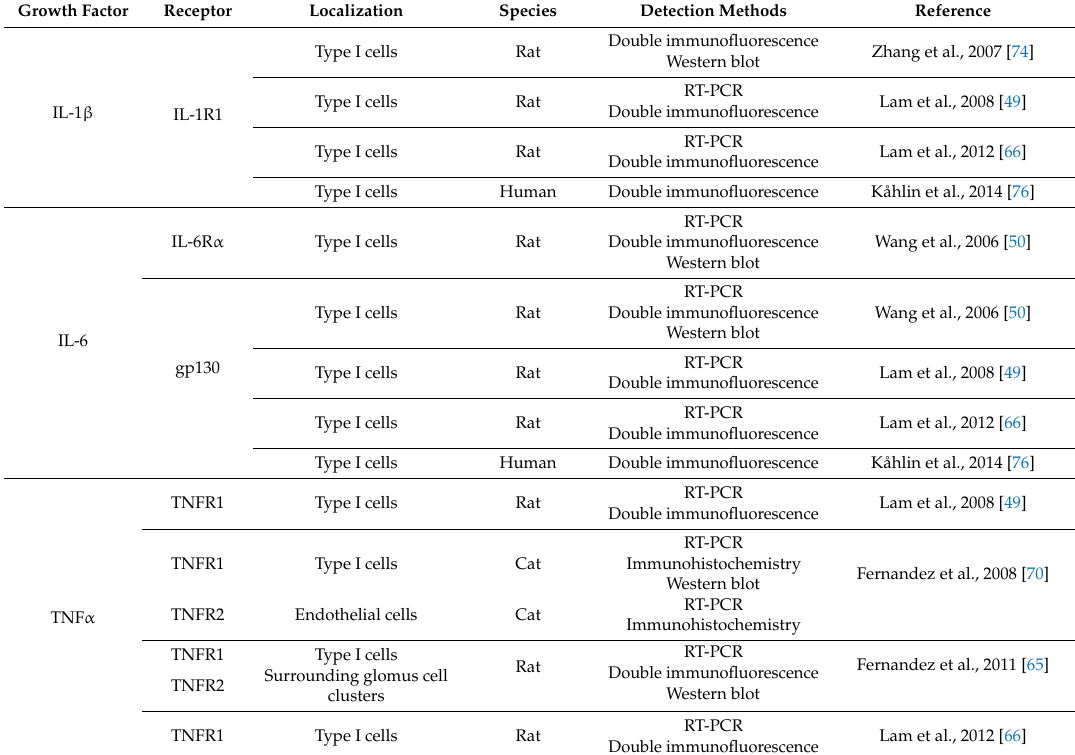
Table 9. IL-1 β , IL-6, and TNF α receptors. Expression of in the carotid